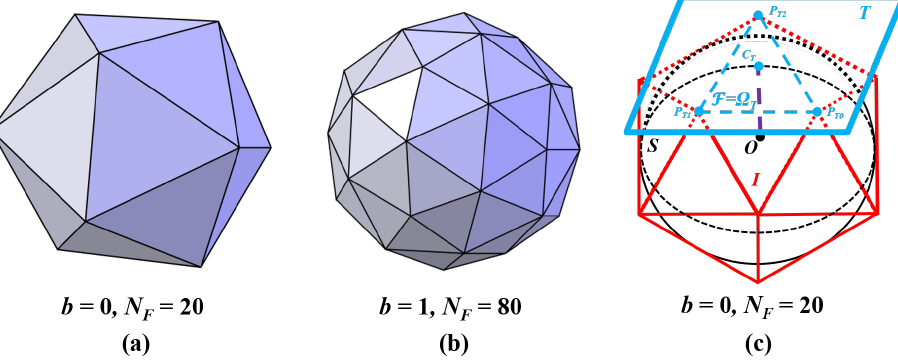
Figure 2. Icosahedron and its use for tangent images (TIs). ( a , b ) showed icosahedron with different subdivision levels b . The increase of b will also increase the number of faces N F . ( c ) showed an icosahedron I fully cover a unit sphere S . The sphere S coincides with the icosahedron face F at centroid C T . We create the TI T by extending the face F . The higher b will offer more TI position C T possibility and lower distortion in the visibility region Ω T = ∆ P T 0 P T 1 P T 2 . The standard planar image processing algorithm works better in the visibility region Ω T than